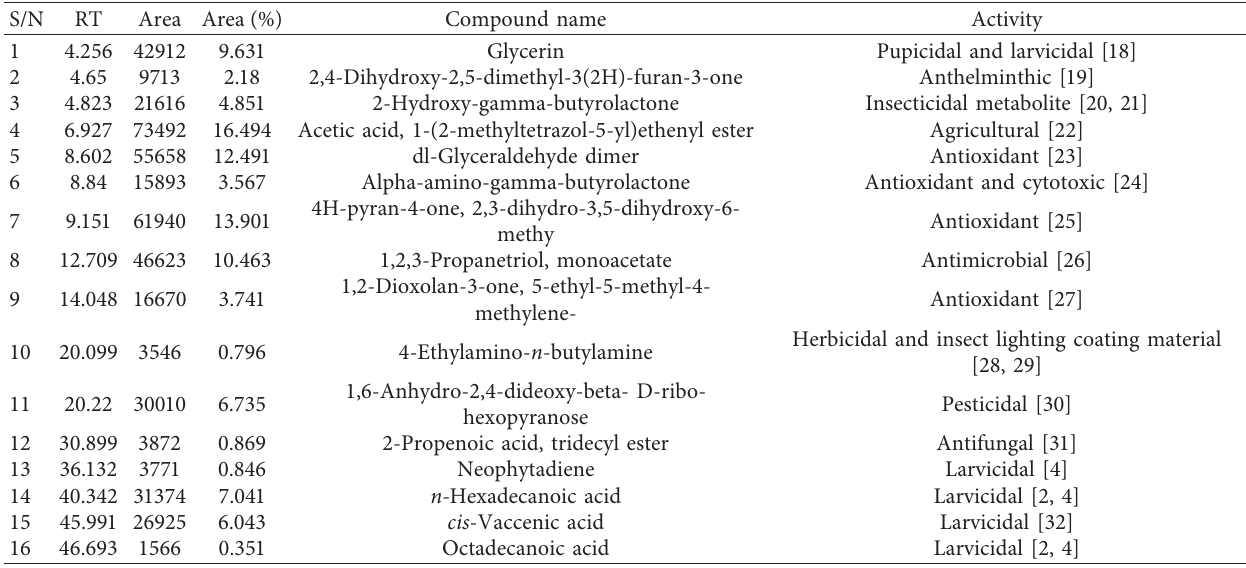
Table 1: Chemical compounds for Clitoria ternatea flower.